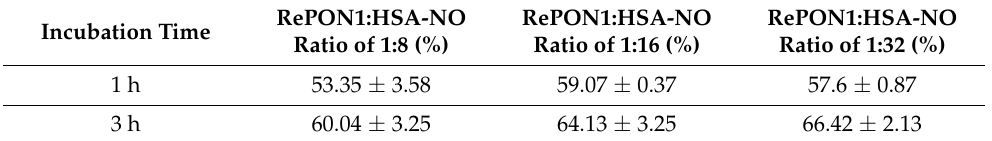
Figure 1. Mass spectra of rePON1 and rePON1-NO obtained by Q-TOF LC-MS. ( A ) Mass spectrum of rePON1 (1.25 µ m) incubated in HEN buffer (50 mm HEPES buffer, 1 mM EDTA, 0.1 mm neocuproine, pH 7). ( B , C ) Mass spectrum of rePON1 (1.25 µ m) after incubation with HSA-NO (10 µ m) in HEN buffer for 1 h ( B ) and 3 h ( C ). Data are mean ± SEM of triplicate wells and are representative of three independent experiments. Statistical analysis by one-way ANOVA and GraphPad prism 8.0.1 software. Table 1. S-nitrosylation after 1 or 3 h incubation with three different concentrations of HSA-NO donor. Incubation